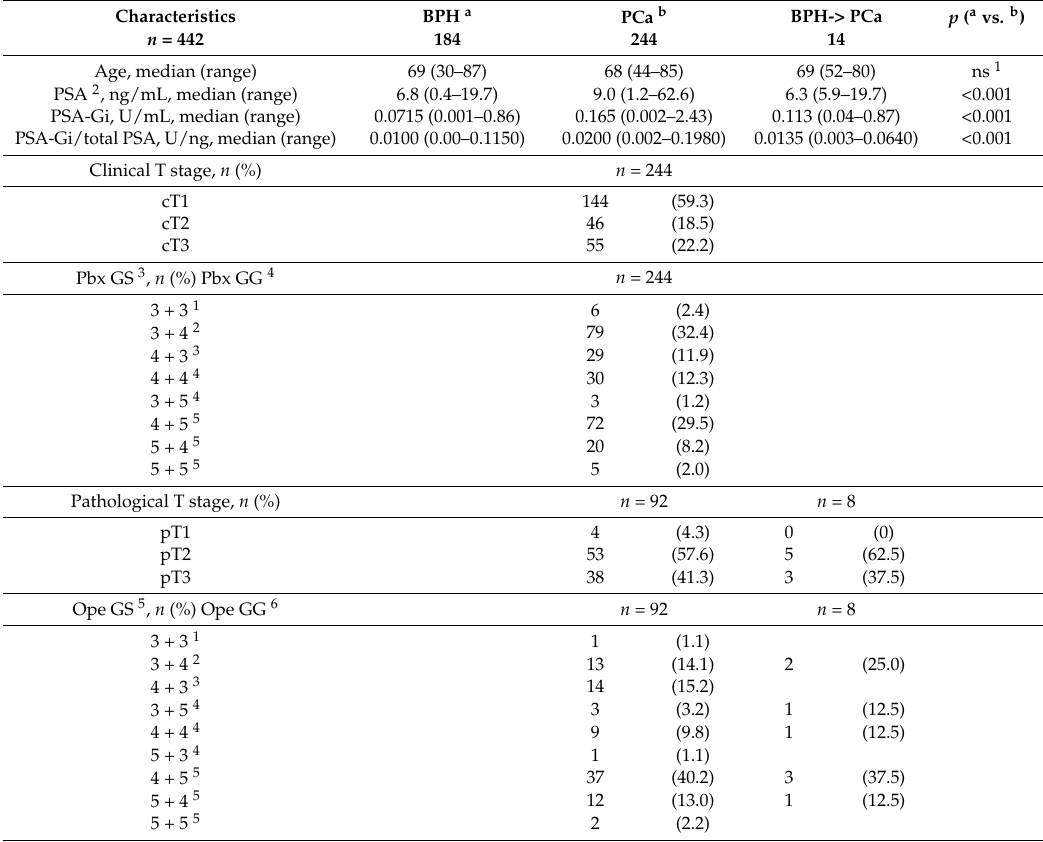
Table 1. Characteristics of BPH patients and PCa patients.